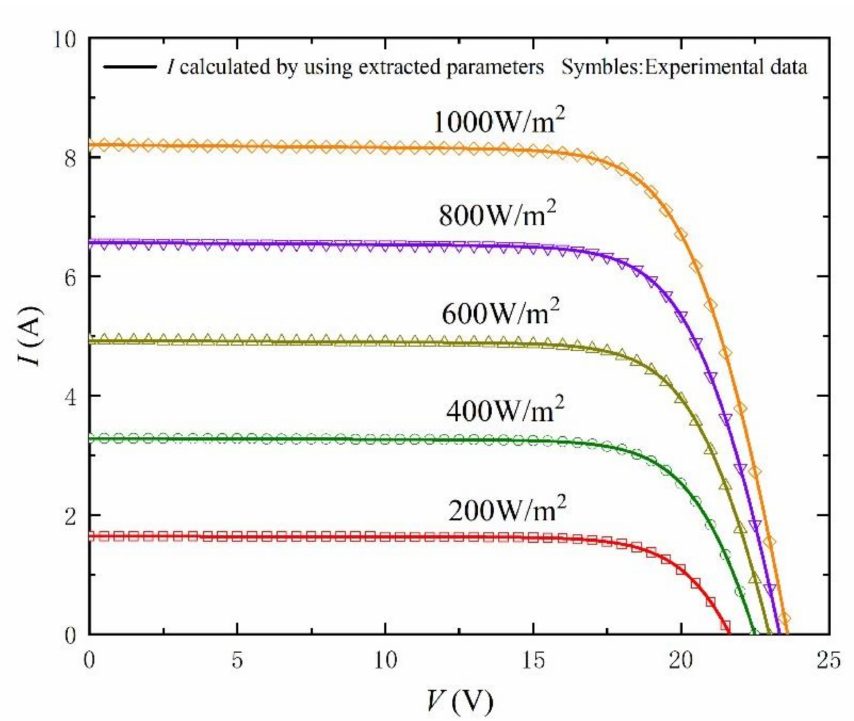
Figure 9. I-V curves measured from experimental data [33] at different irradiance levels and T = 25 ◦ C, and calculated by using the extracted parameters listed in Table 3.